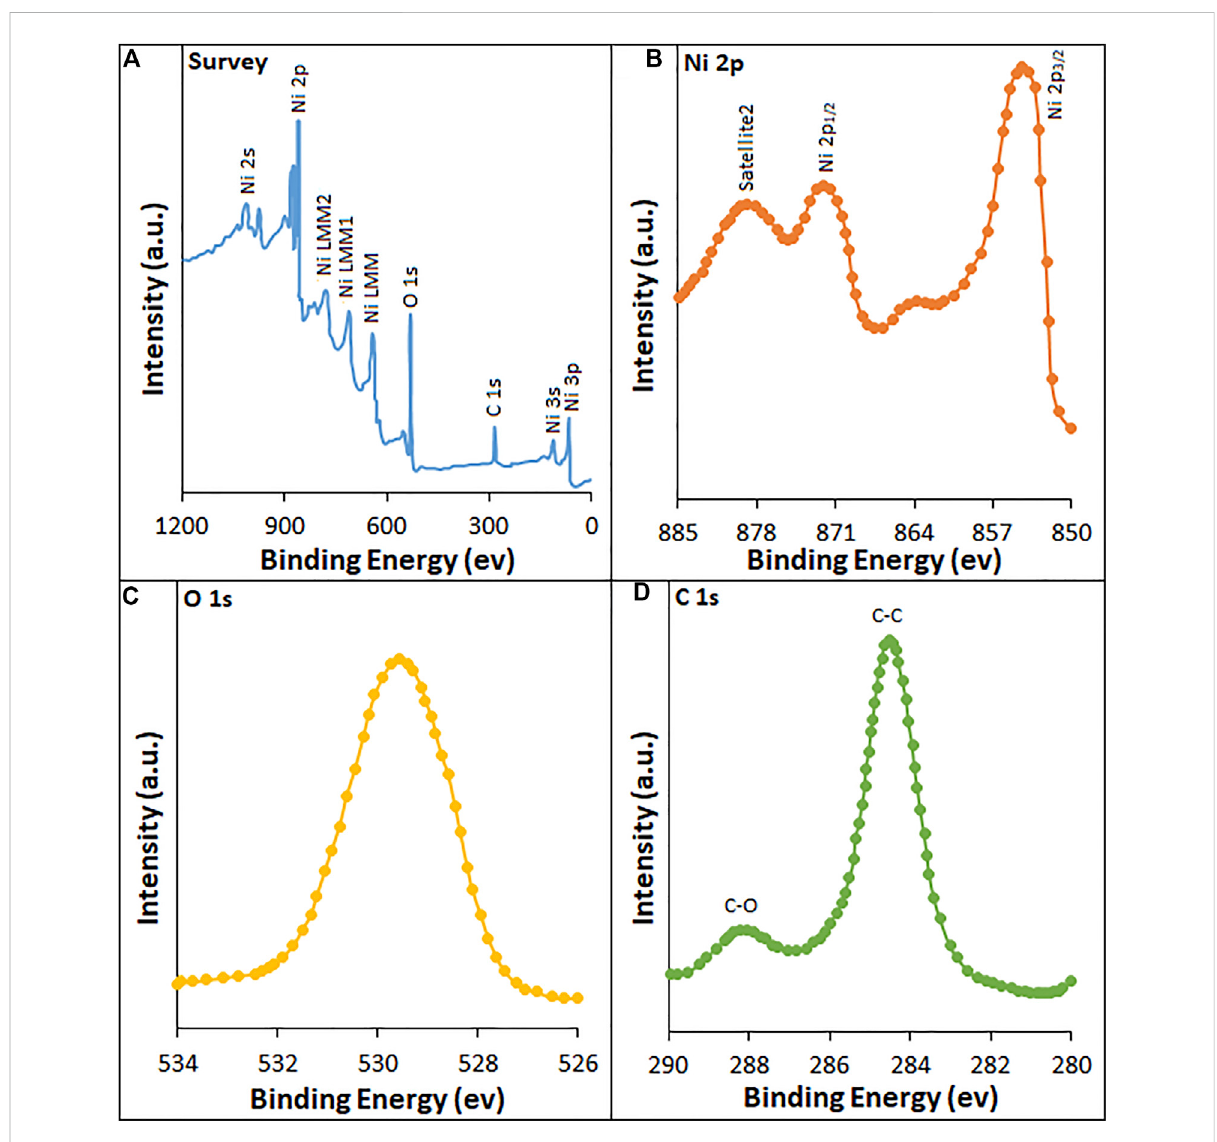
FIGURE 4 XPS spectra of HG-NiO-NDs: (A) survey; high-resolution spectra of (B) Ni 2p, (C) O 1s, and (D) C 1s.